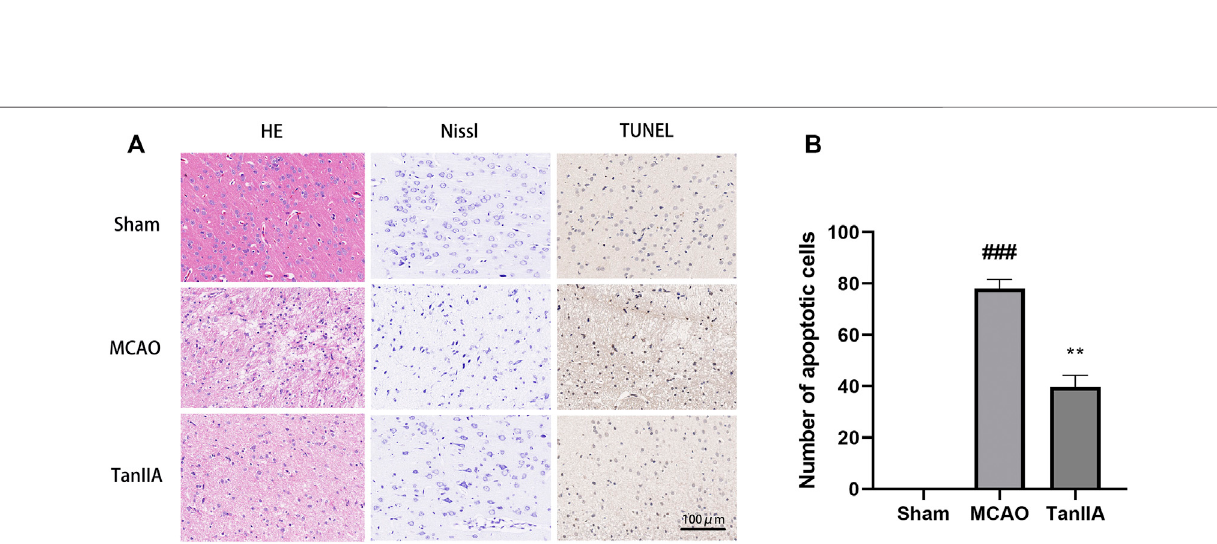
Frontiers in Pharmacology |